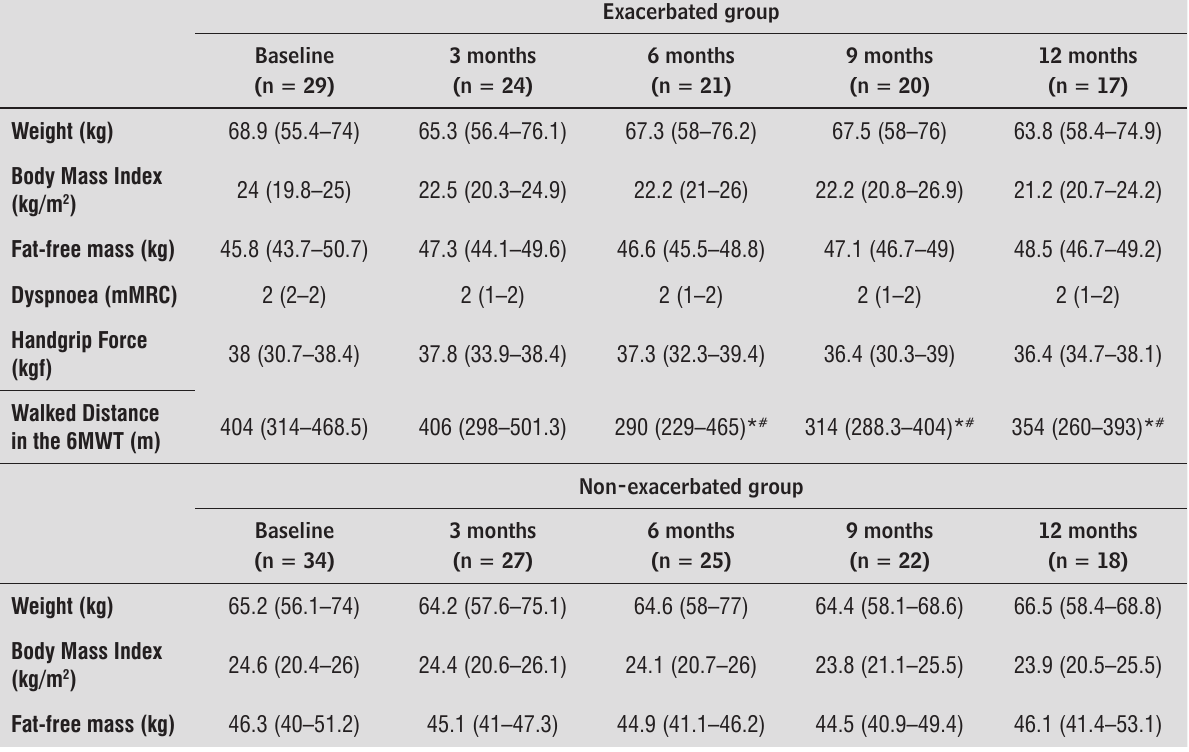
Table 2 - Body Composition, dyspnoea, handgrip force of both groups over the 12-month follow